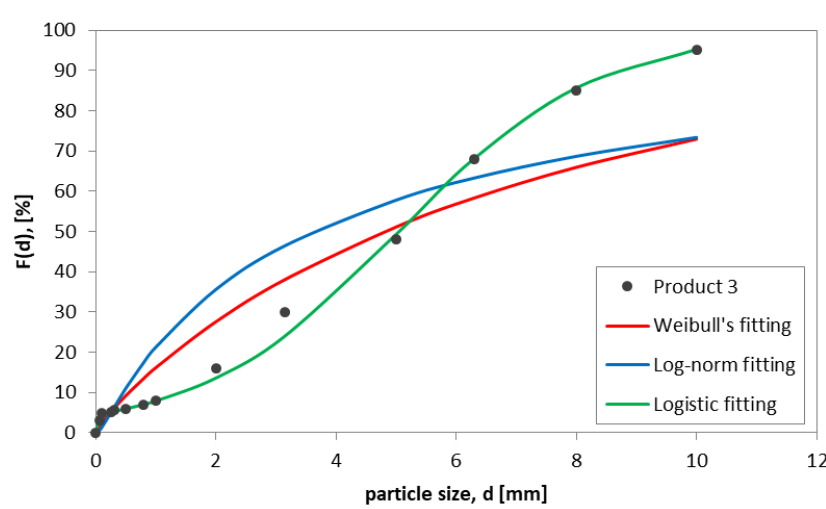
Figure 4. Fitting results for product 2.